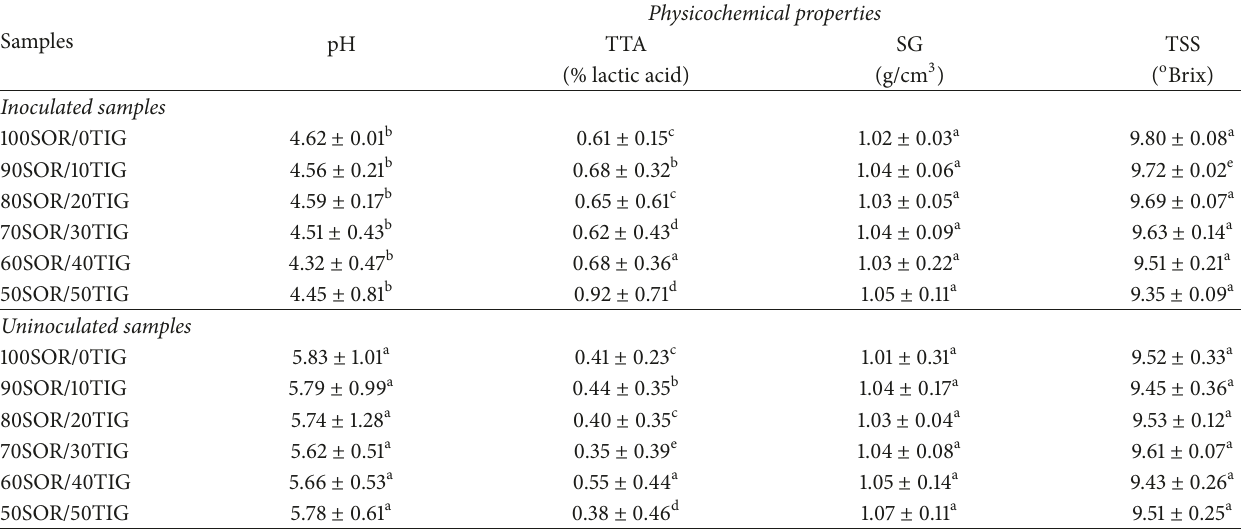
Values are means of three replicated samples. Means with different superscript letters across columns are significantly different (𝑝 < 0.05) ; TTA, total titratable acidity; SG, specific gravity; TSS, total soluble solids; 100SOR/0TIG, 100 % sorghum and 0 % tigernut; 90SOR/10TIG, 90 % sorghum and 10 % tigernut; 80SOR/20TIG, 80 % sorghum and 20 % tigernut; 70SOR/30TIG, 70 % sorghum and 30 % tigernut; 60SOR/40TIG, 60 % sorghum and 40 % tigernut; 50SOR/50TIG, 50 % sorghum and 50 %